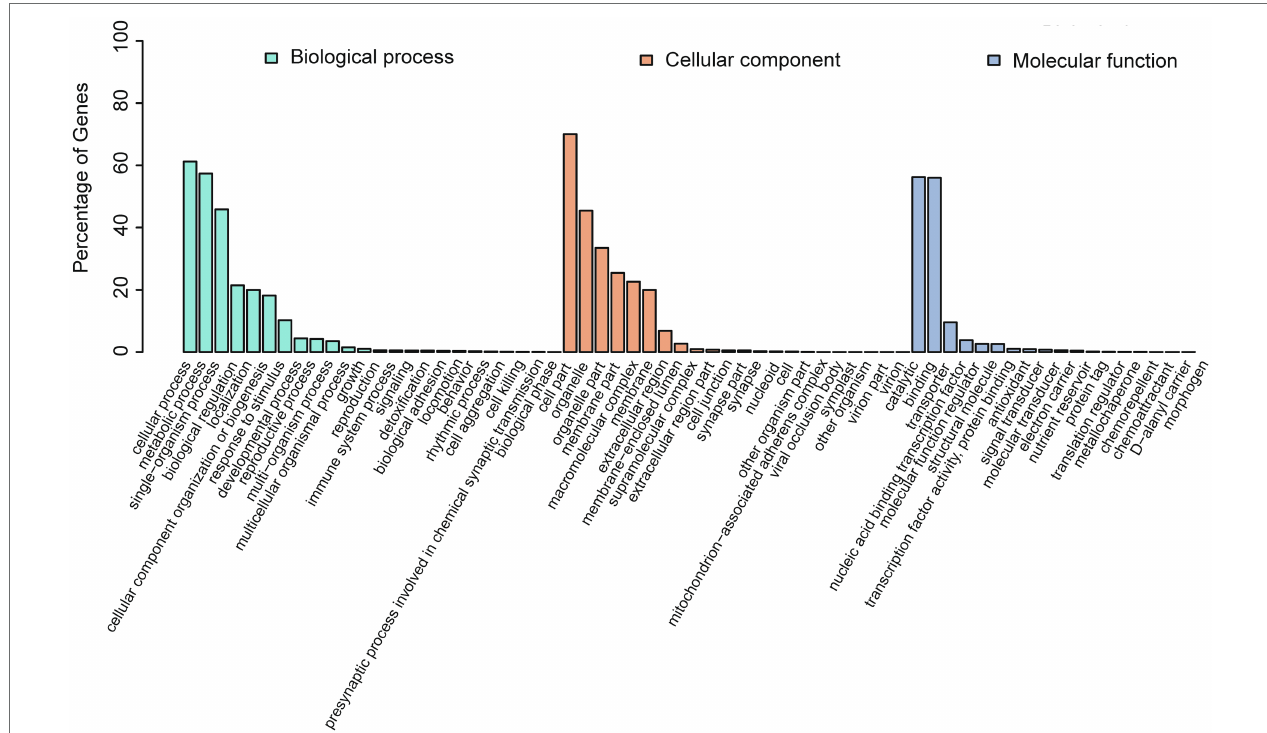
FIGURE 7 | GO annotation of the predicted genes in A. alternata (Y784-BC03). The abscissa is the GO classification, and left ordinate is the percentage of the number of genes. This figure reveals the gene enrichment of the differentially expressed upregulated and downregulated genes. The column colors represent biological_process (green), cellular_component (red), and molecular_function